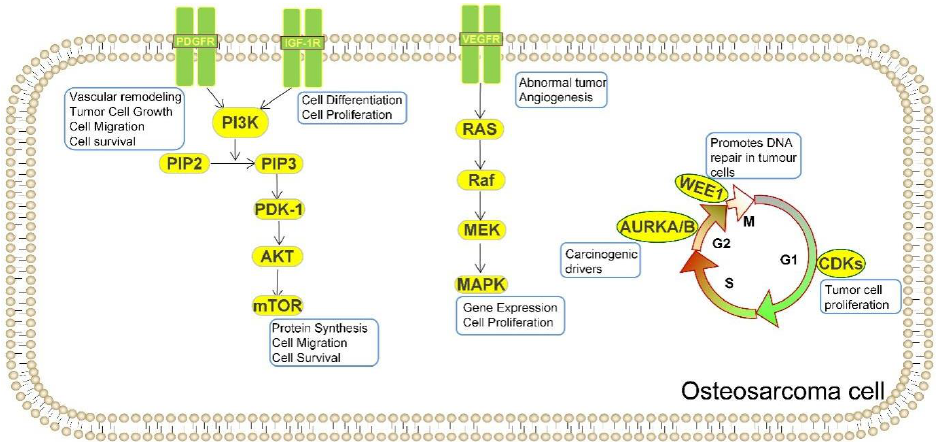
Figure 2. Important targets for osteosarcoma therapy and their main functions. Various receptors capable of acting as targets in OS cells serve different purposes. PDGFR promotes the survival and migration of OS cells, IGF-1 receptor promotes their differentiation; these two receptors can work together to produce mTOR in the PI3K pathway to enable OS cells to proliferate and metastasize. In addition to its vasculogenic role, VEGFR activates MEK, which has the effect of promoting OS gene expression. In addition to its angiogenic effects, VEGFR activates MEK, which also makes a